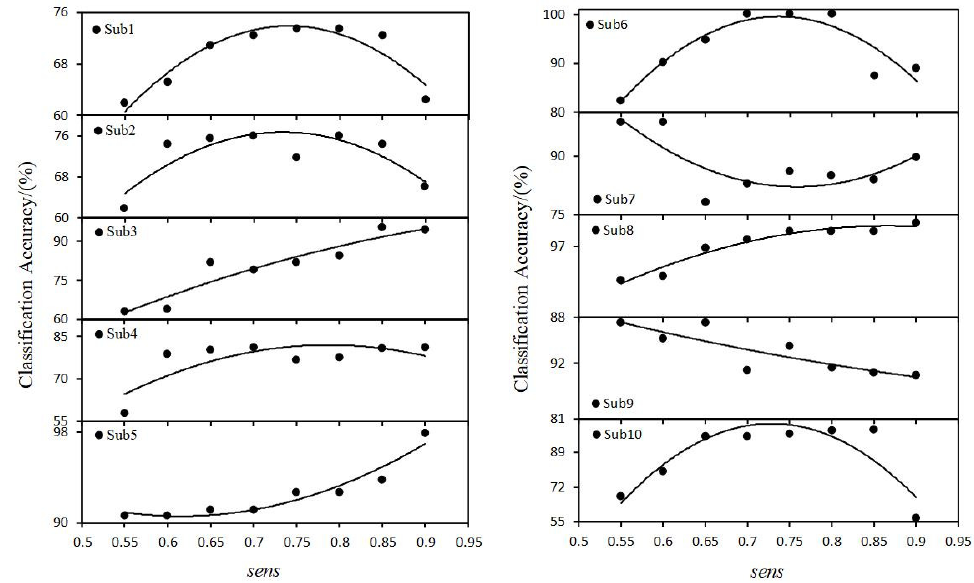
Figure 6. Comparison of MW classification accuracy corresponds to different sensitivity coefficient thresholds. Table 2. Classification results with optimal and worst sens .